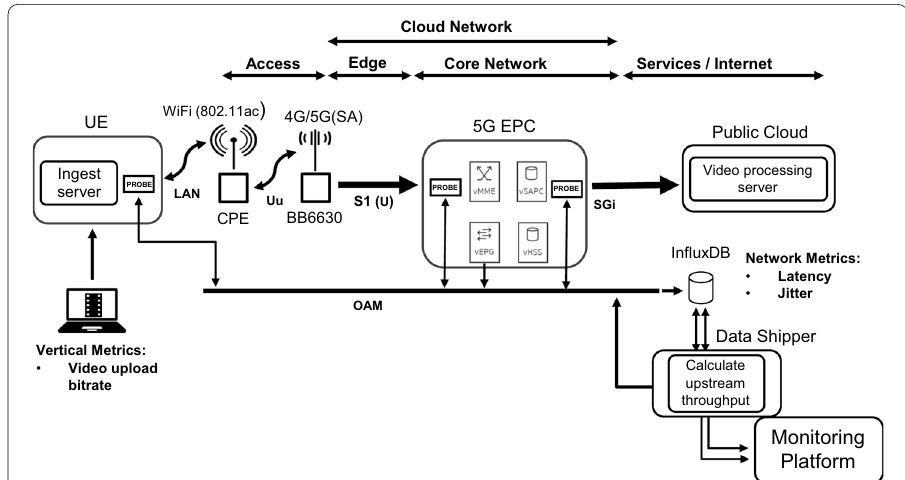
Fig. 3 Monitoring of the upstream throughput in a 5G use case. Adapted from